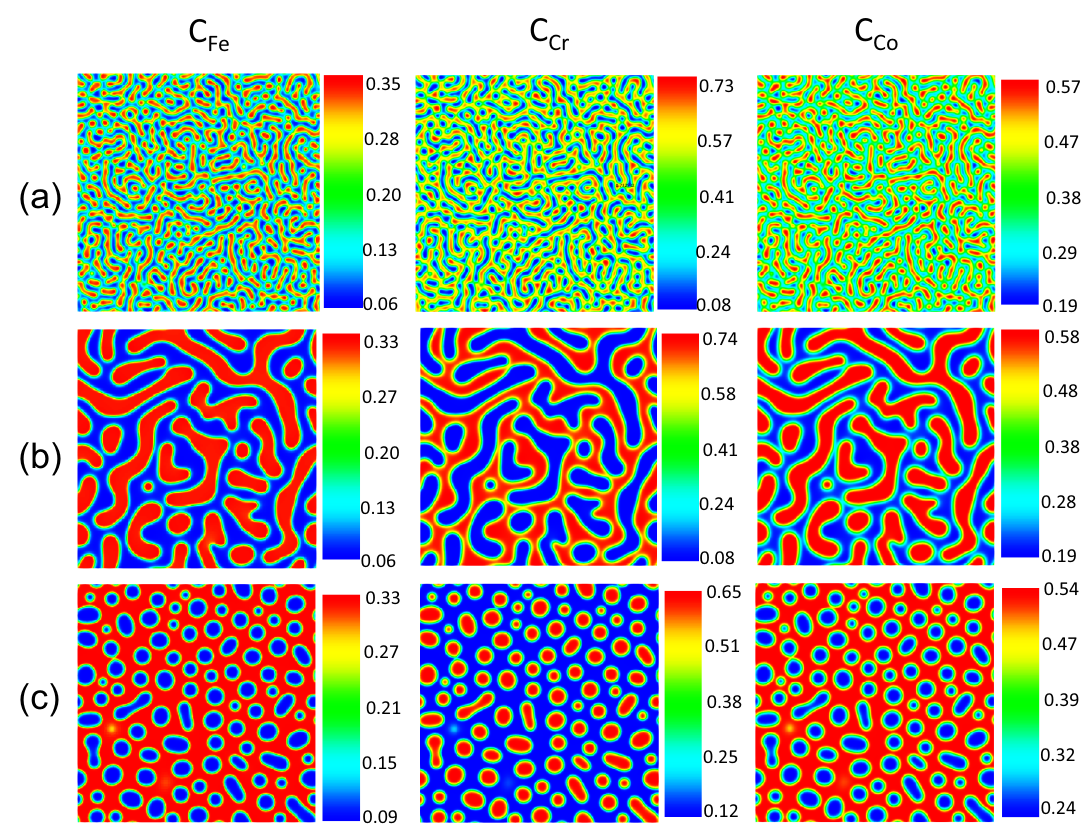
Figure 3. Fe–Cr–Co alloys microstructure generated by the phase-field method for: ( a ) Fe-20%, Cr-40%, Co-40% at 873 K, ( b ) Fe-20%, Cr-40%, Co-40% at 963 K, ( c ) Fe-25%, Cr-30%, Co-45% at 933 K. (Composition are in atomic percent).